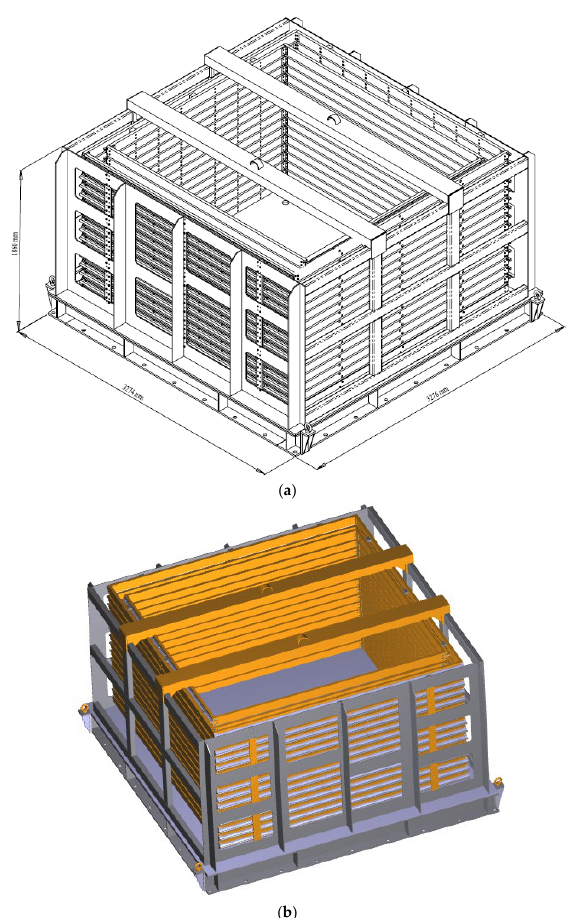
Figure 23. ( a ) The isometric and ( b ) 3D views of the laminar shear box.